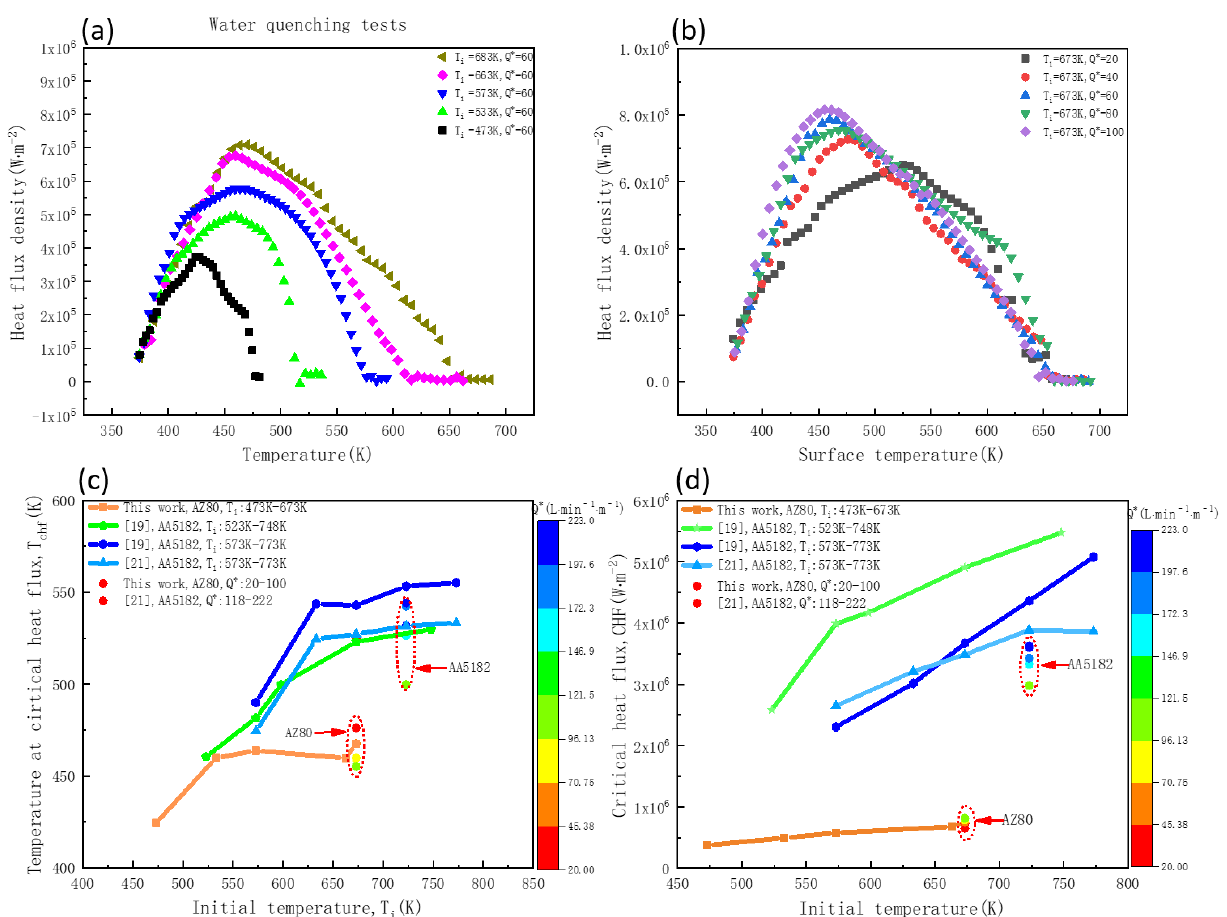
Figure 14. Variations of boiling curves, CHF and T chf with different T i and Q ∗ by DC secondary cooling simulator tests: ( a ) boiling curve with different T i at 473, 523, 573, 623, 673 K, respectively, and the same Q ∗ at 60 L min − 1 m − 1 ; ( b ) boiling curve with different Q ∗ at 20, 40, 60, 80, 100 L min − 1 m − 1 and the same T i at 673 K; ( c ) the variations of T chf at different T i ; ( d ) the variations of T chf at different Q ∗ .